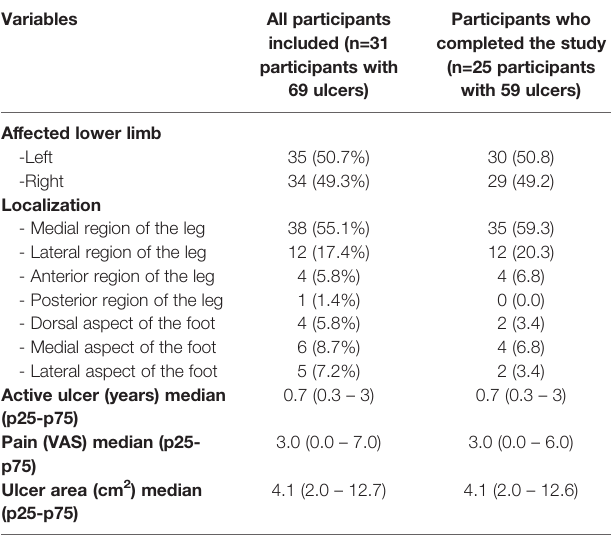
TABLE 3 | Distribution of ulcers from all participants included and from those who completed the study according to their clinical characteristics at baseline. Variables All participants included